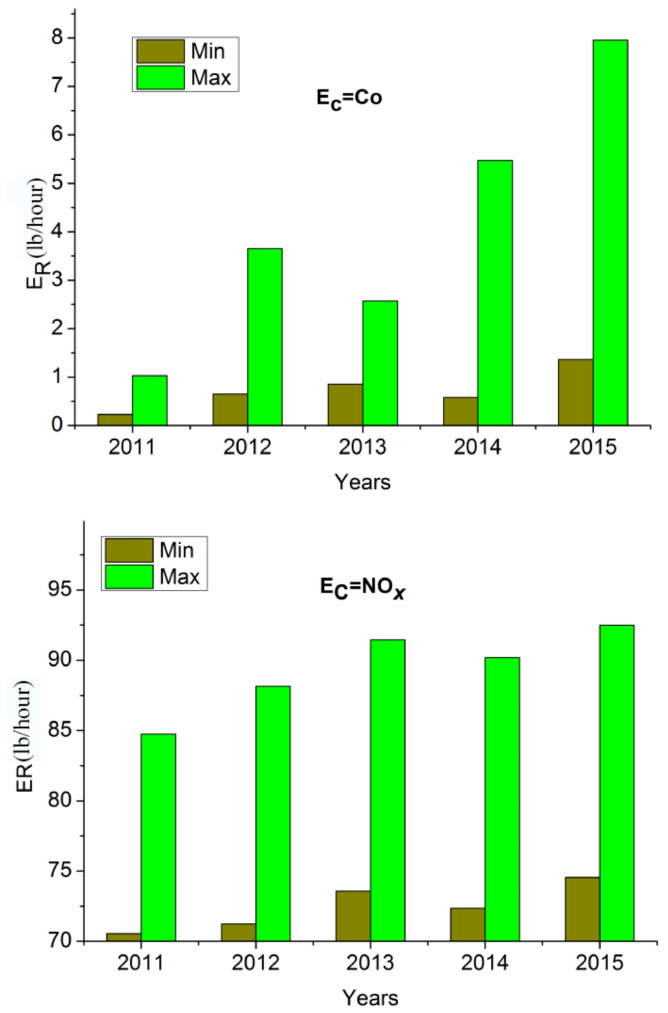
Figure 6. Emission rate E R for carbon monoxide C o and nitric oxide NO X